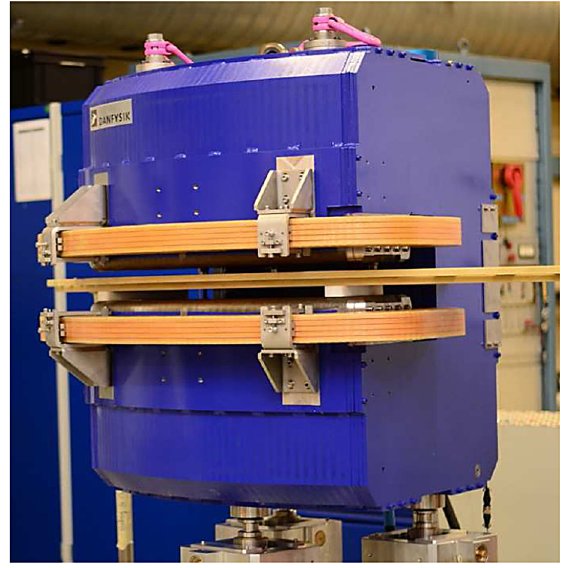
FIG. 4. Picture of ELENA preseries magnet during magnetic